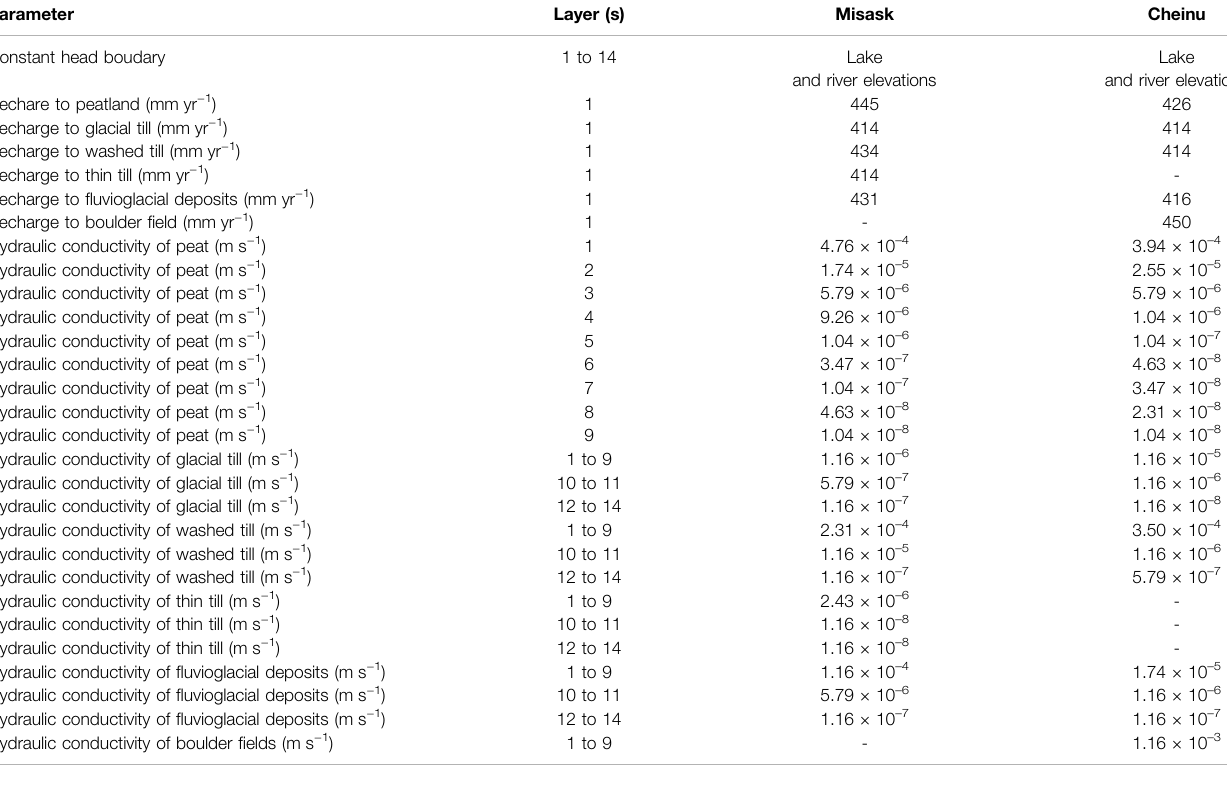
TABLE 3 | Calibrated model parameters for the Misask and Cheinu peatlands.